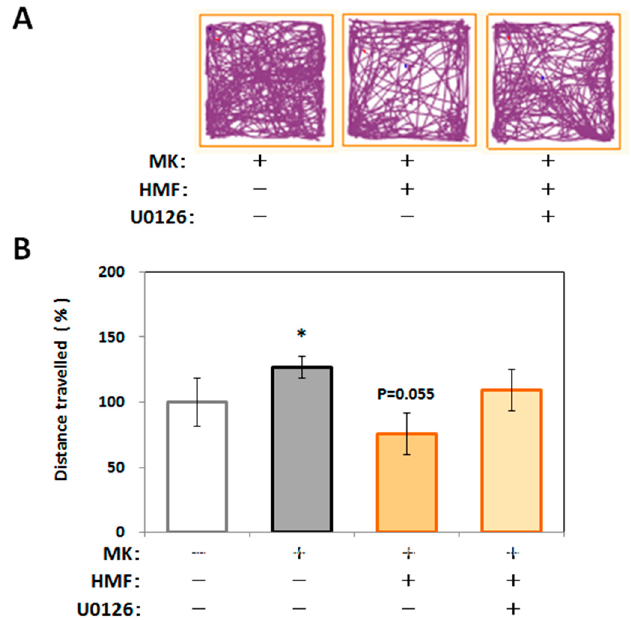
Figure 7. Effect of U0126 on the spontaneous locomotive behavior of MK-801 and/or HMF-injected mice in the open field test. ( A ) Representative traces during 10 min; ( B ) Total distance traveled in the open field test during the 10-min period. Values (% control) are the means ± SEM. * p < 0.05 vs. control group. p = 0.055 vs. MK group.